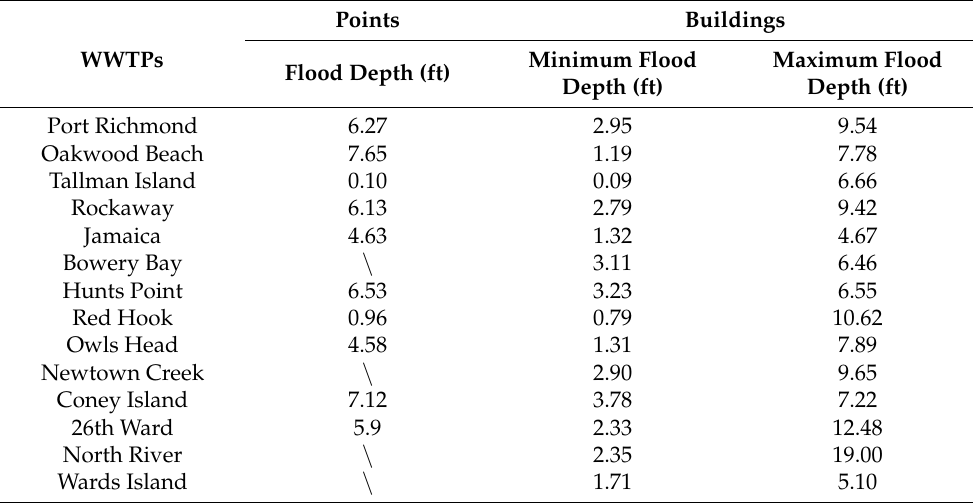
Table 8. Comparison when considering WWTPs as points vs. buildings for a SLOSH category 2